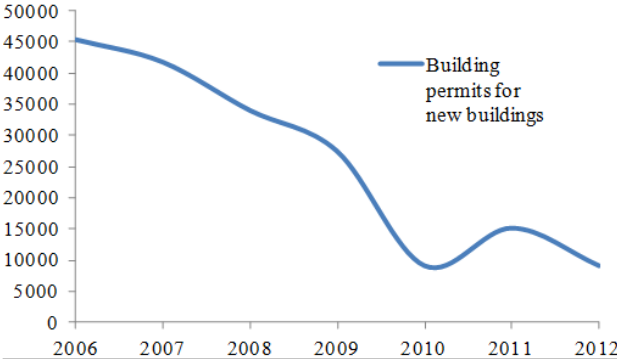
Figure 3. Number of building permits for new buildings per year, from 2006 to 2012 in Greece (Source: [50]).